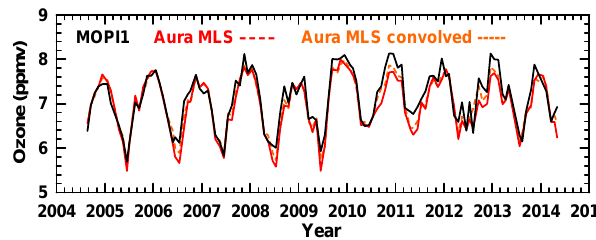
Figure 6. Monthly ozone averages for MOPI1 (black), Aura MLS (red), and Aura MLS convolved with the MOPI averaging kernels (dashed orange) measurement pairs at 10hPa. Measurements are shown when there is an MLS measurement taken within ± 1 ◦ lati- tude and ± 6 ◦ longitude within 6h of a MOPI measurement.